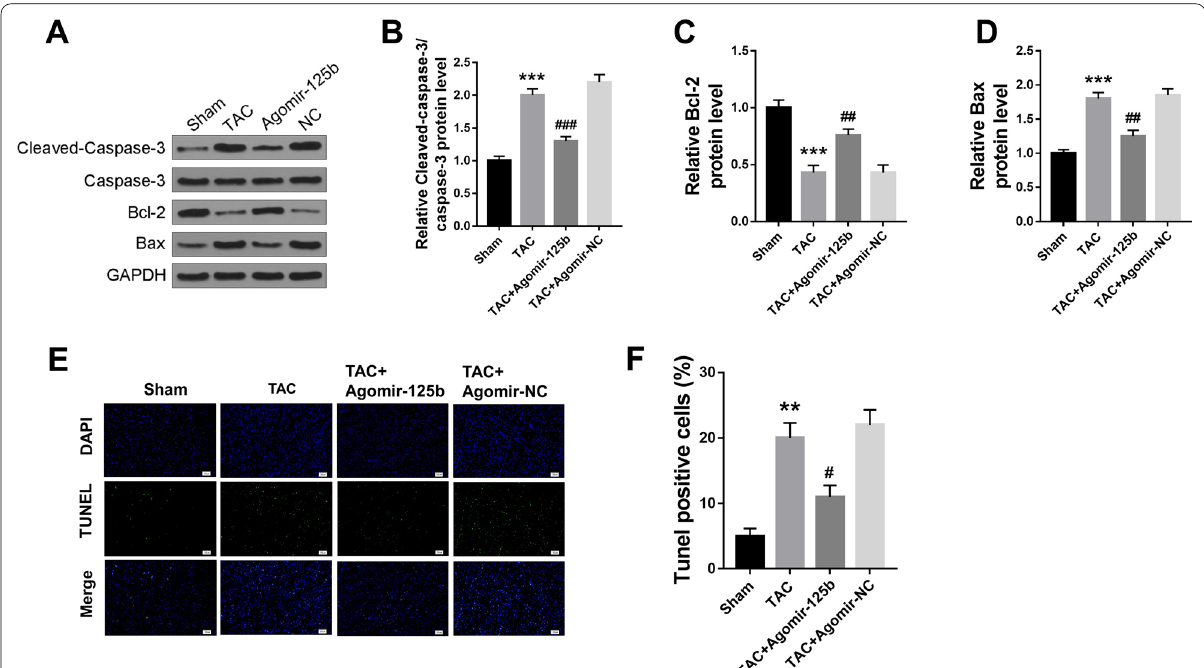
Fig. 3 MiR-125b overexpression inhibited cardiomyocyte apoptosis in HF mice. Mice were treated with or without TAC. TAC mice were tail intravenously injected with agomir-125b or agomir-NC. A The protein expression of C-caspase 3, caspase 3, Bcl-2 and Bax in heart tissues was detected by Western blot (n 5). B – D The relative expression changes in C-caspase 3 ( B ), Bcl-2 ( C ) and Bax ( D ) were analyzed by Image Lab ™ = Software (n 5). E Representative images of TUNEL staining of heart tissues by confocal microscopy (n = the ratio of TUNEL positive nuclei to DAPI-stained nuclei (n vs. TAC